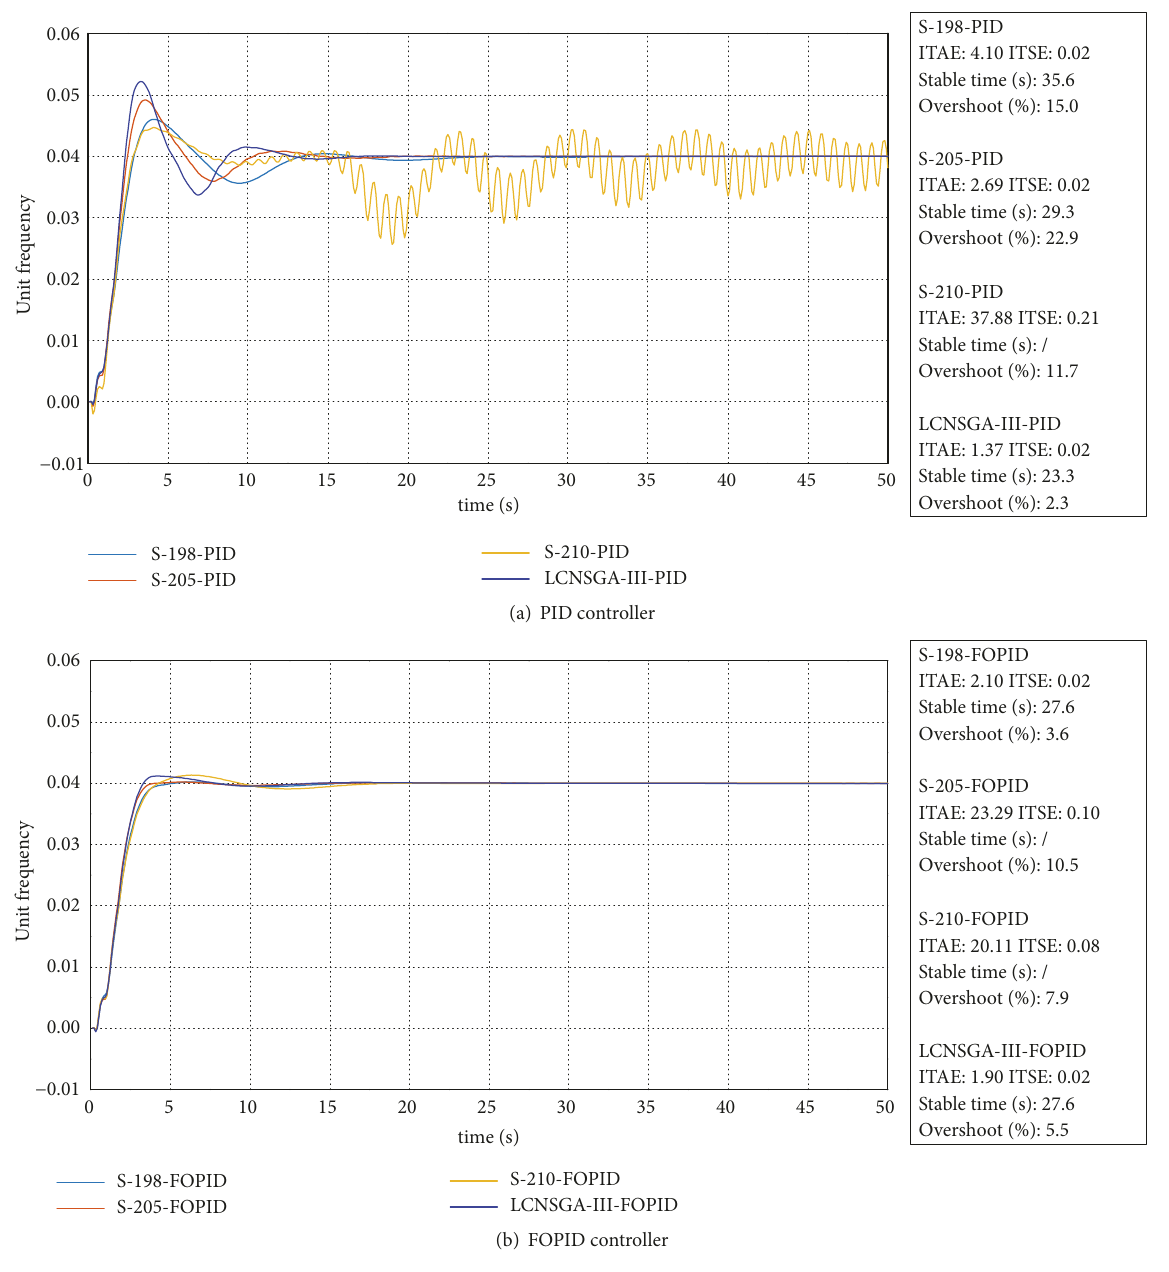
Figure 8: Unit frequency obtained at 205m working water